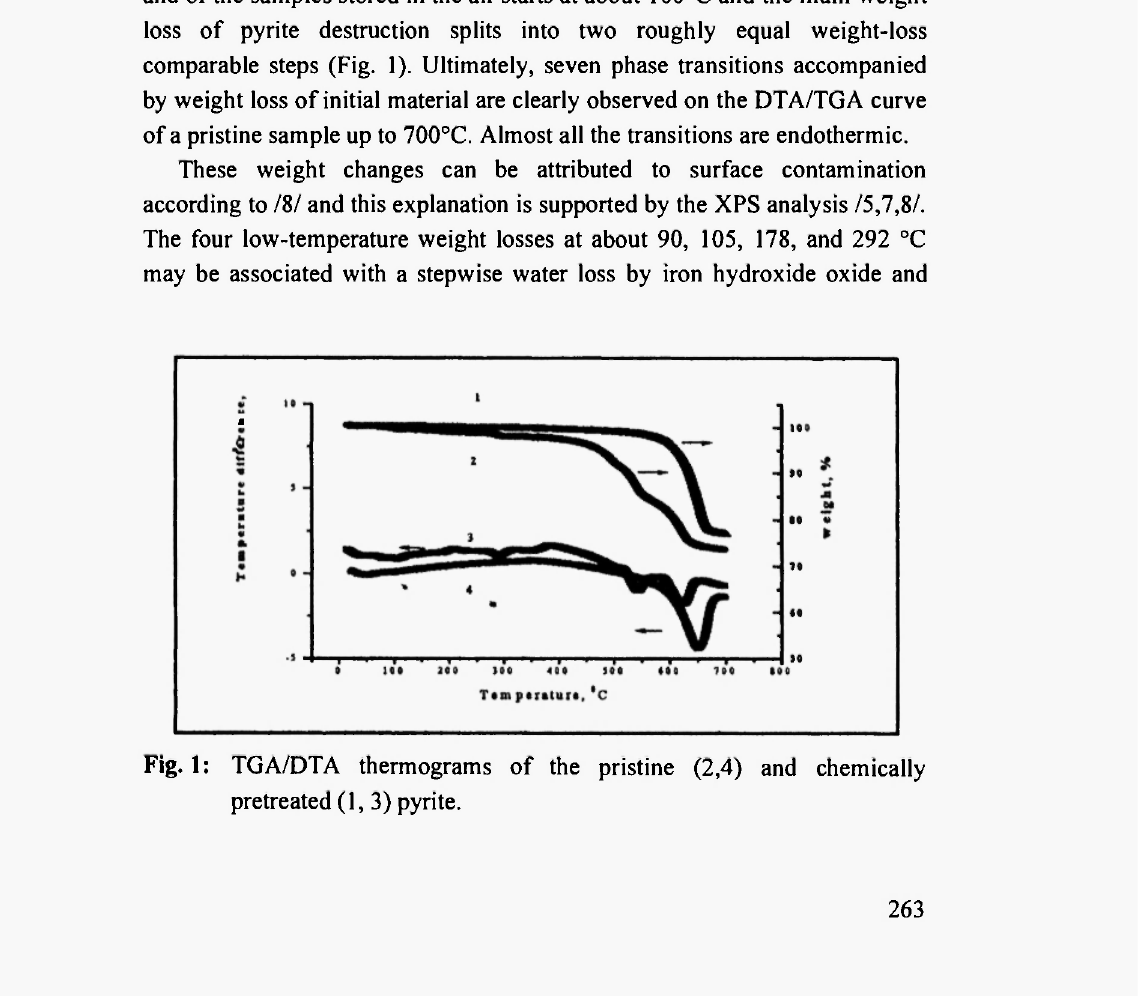
Fig. 1: TGA/DTA thermograms of the pristine (2,4) and chemically pretreated (1,3)